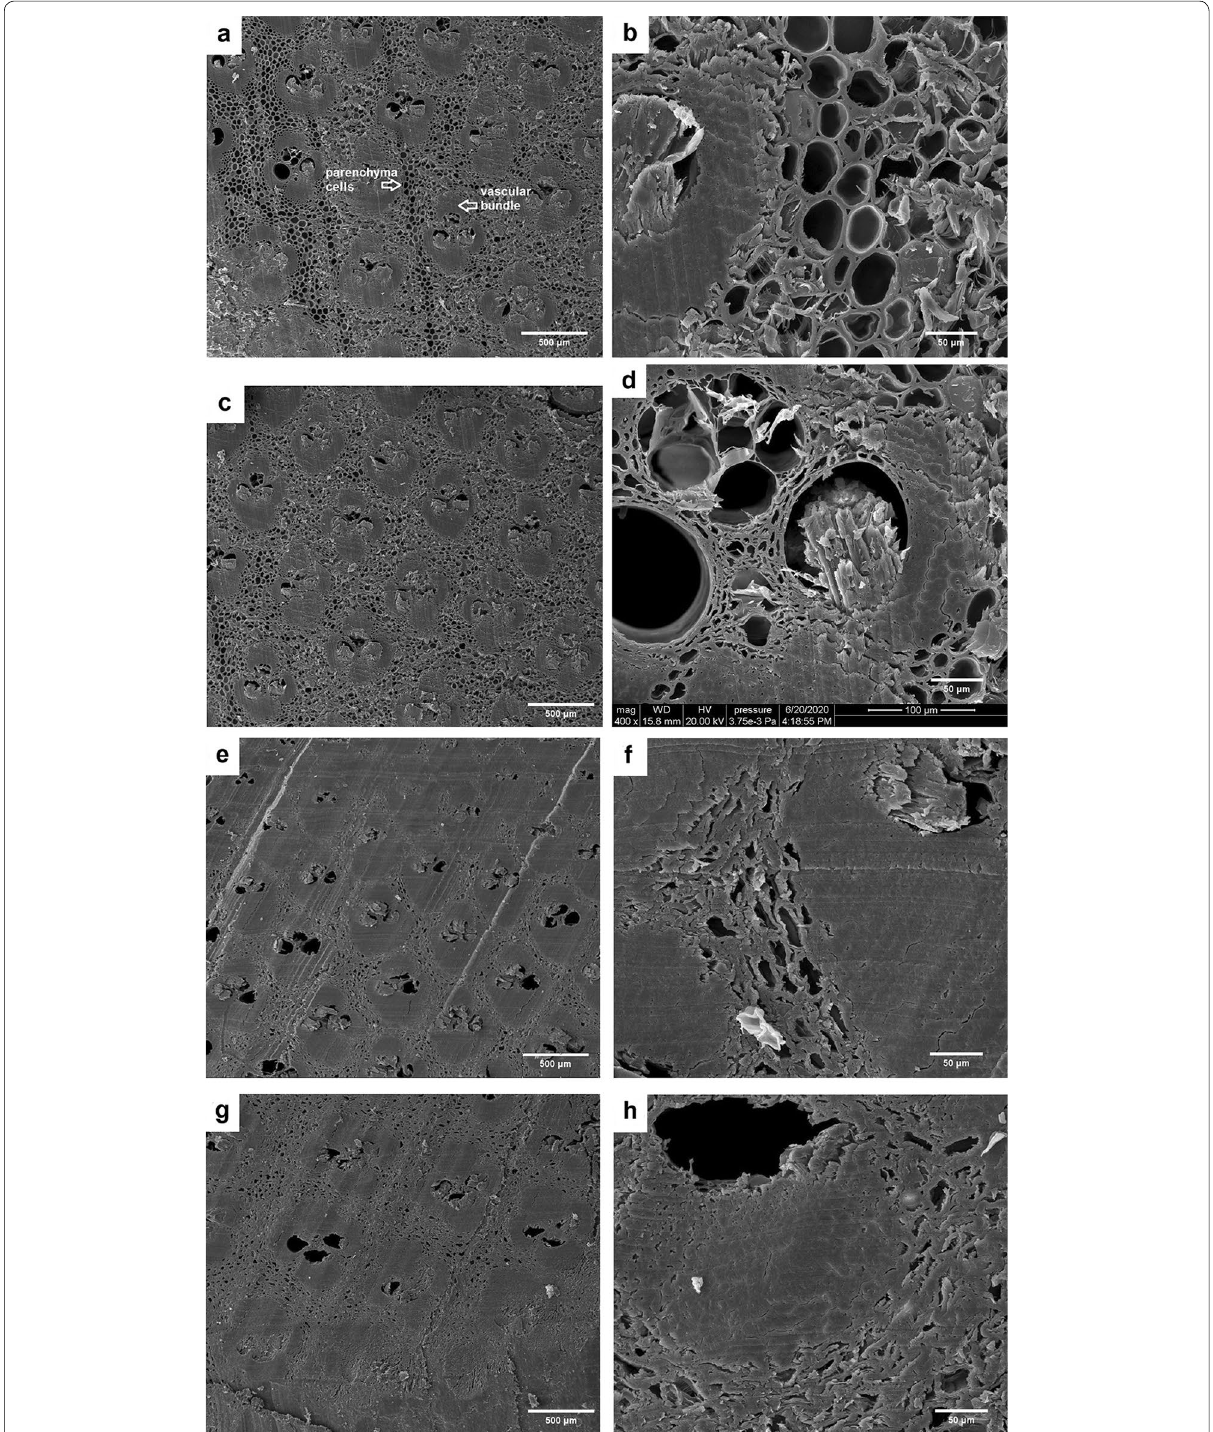
Fig. 2 SEM images on the cross-section of bamboo culms at different treatment conditions: ( a ) and ( b ) untreated; ( c , d ) 140 °C/30 min; ( e ) and ( f ) 160 °C/30 min; ( g ) and ( h ) 180 °C/10 min; ( i ) and ( j ) 180 °C/30